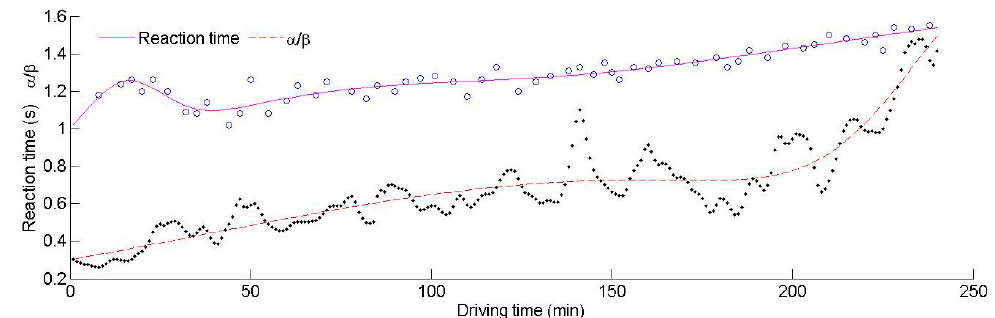
Figure 4. The reaction time and α / β as time increases.